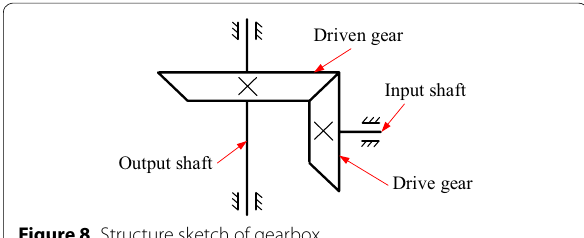
Figure 8 Structure sketch of gearbox